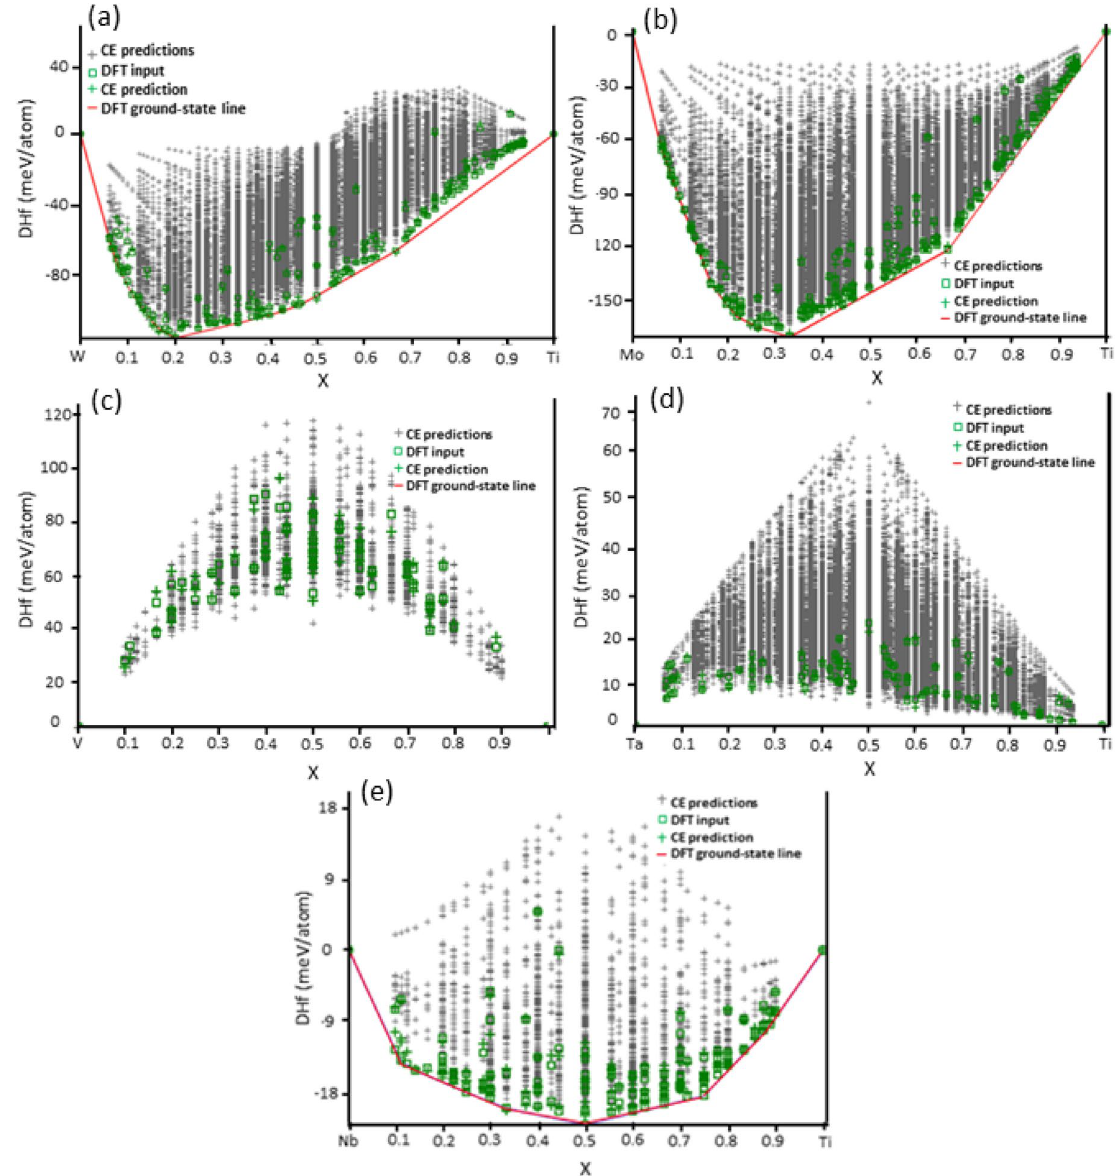
Figure 1. The convex hull plots of binary Ti-X (X = W, Mo, V, Ta, and Nb) β-phase alloys obtained using cluster expansion method. ( a ) Ti–W ( b ) Ti-Mo ( c ) Ti-V ( d ) Ti-Ta and ( e ) Ti-Nb alloys. The CE predictions (grey symbols) represent the structure space within which the ground state structures are identified, while the red CE entries represent the CE training-set structures for which DFT energies are